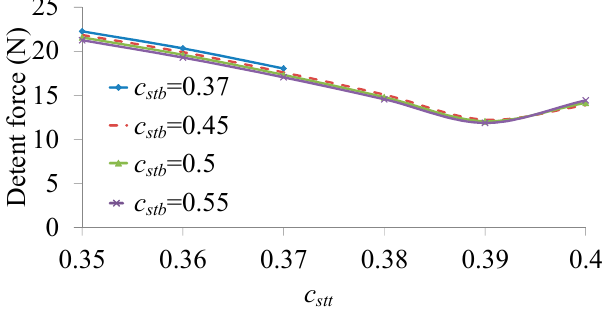
Figure 9. Detent force peak-to-peak value with different c stt and c stb .